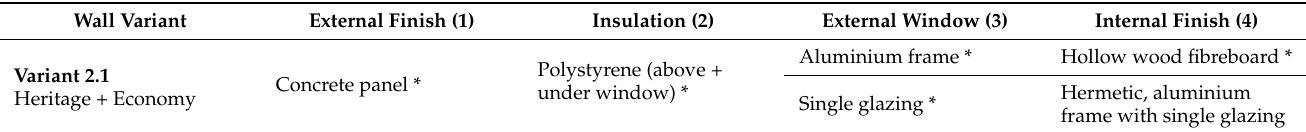
Figure 8. 3D model of the façade module of case study 2 student housing renovation, consisting of sub-modules: (1) external finish, (2) insulation, (3) external window and (4) internal finish. Source: MAKER Architecten [57]. Table 4. The main components of the four external wall variants included in case study 2 student housing renovation. The existing components are indicated with *. The numbers between () in the top row correspond with the numbers in Figure 8.